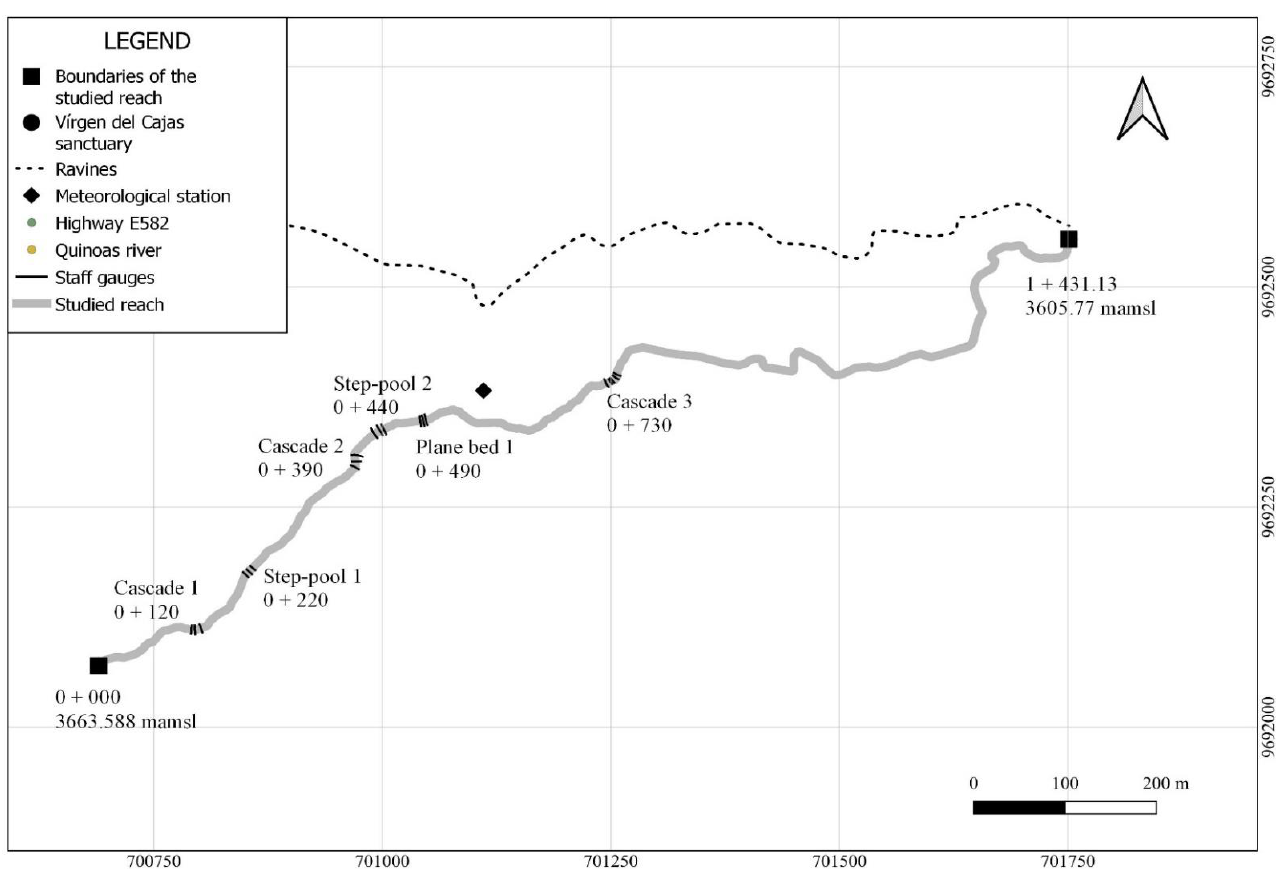
Figure 1. Plan view of the studied 1500 km river reach showing the sequence of the sub-reaches and the location of the meteorological station.